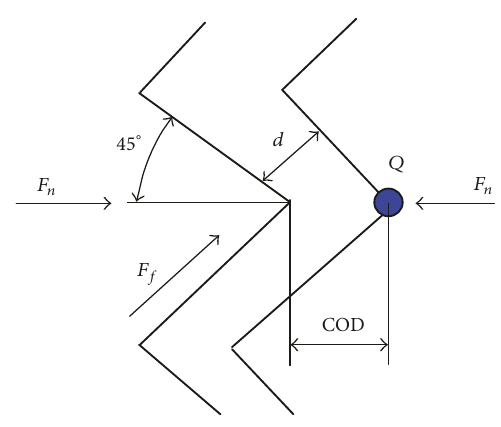
Figure 6: Friction model of crack surface.